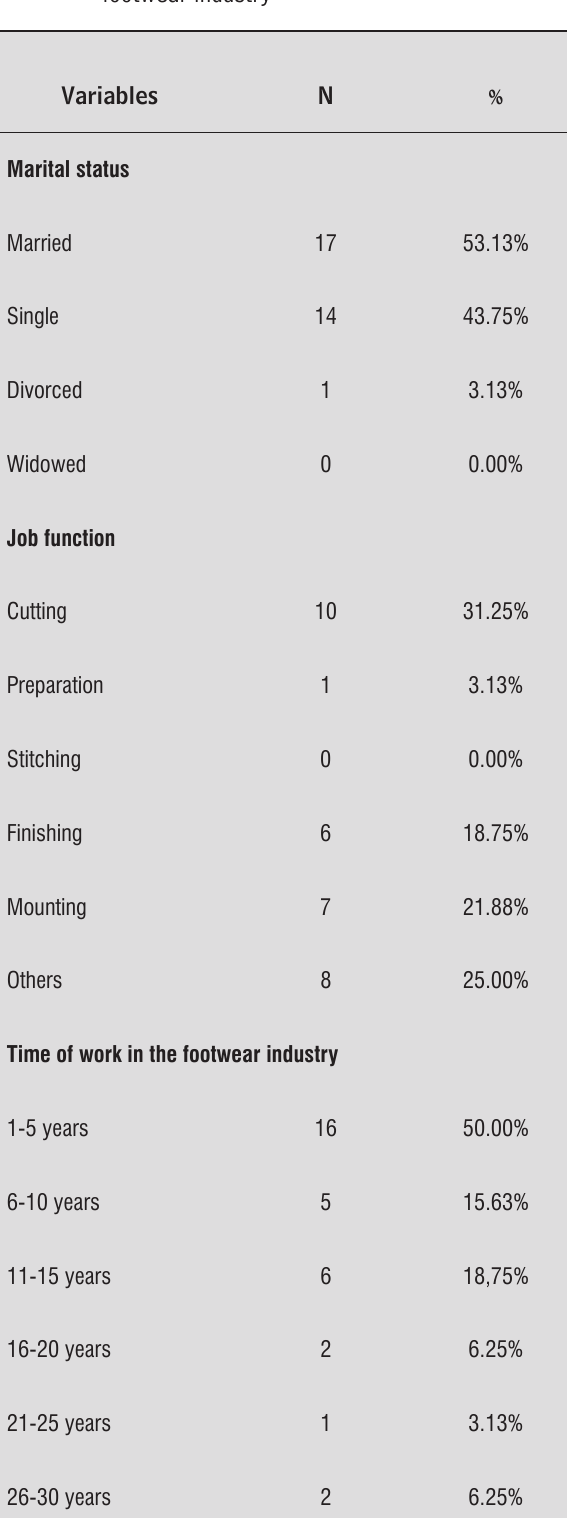
Table 1 - Distribution of workers according to marital status, job function and time of work in the footwear